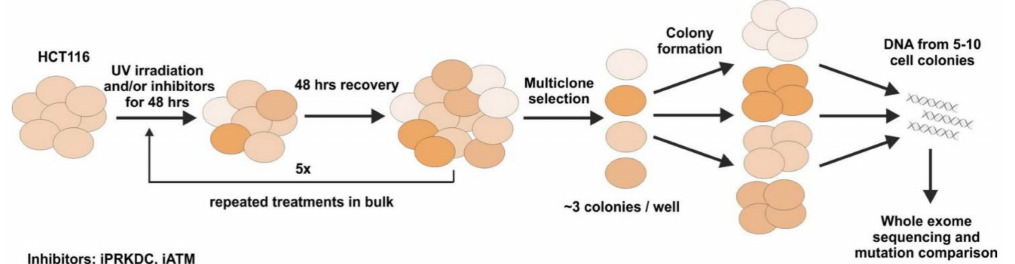
Figure 4. Experimental overview of the in vitro experiments. Cell lines were treated with UV to induce DNA damage and inhibitors against PRKDC and ATM . Five rounds of treatment with recovery periods were applied. Multiclone cell colonies (approx. three colonies/well) were cultured in 96-well plates. DNA was extracted from approximately 10 colonies, creating a polyclonal mixture, where drug-induced mutations were amplified over detection thresholds. Samples were subjected to whole-exome sequencing for mutation